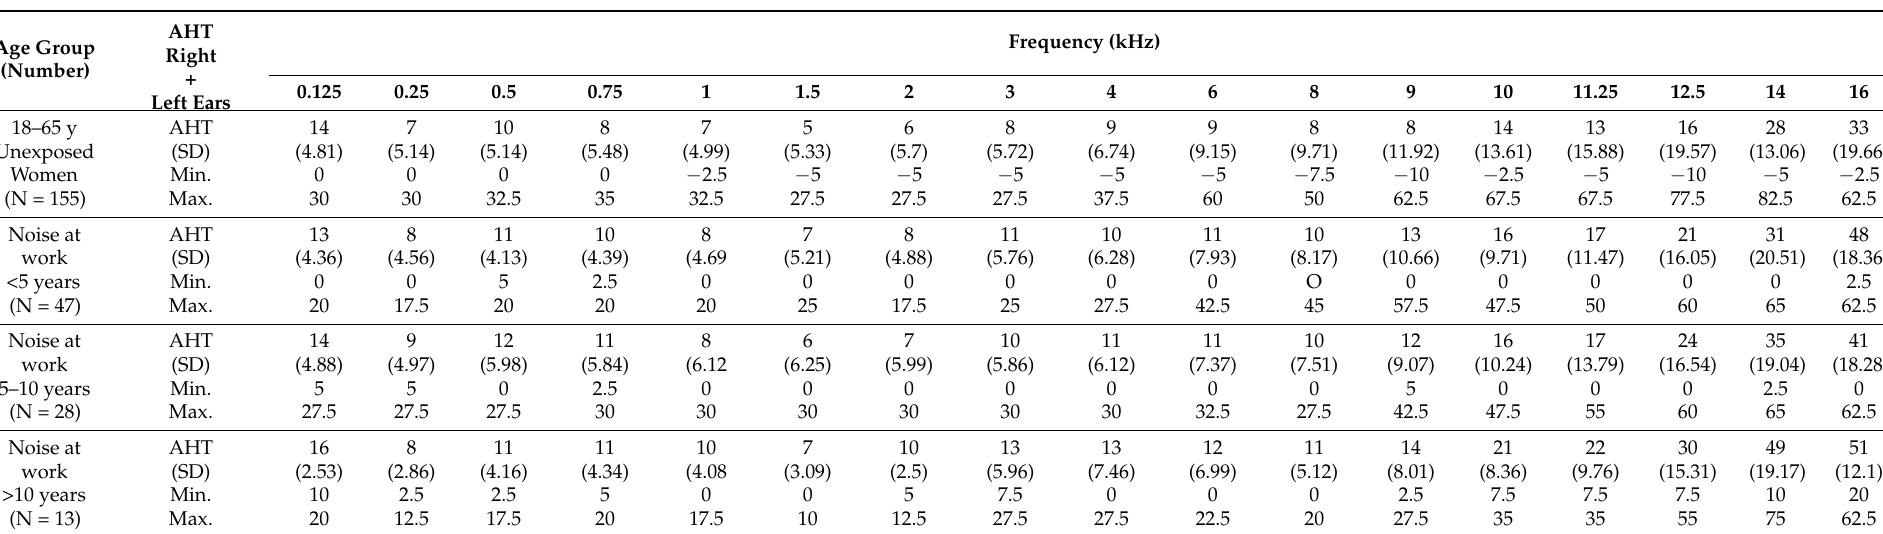
Table 3. Average values, standard deviations, and minimum and maximum hearing thresholds of women unexposed and exposed to noise, depending on the length of work-related exposure to noise.